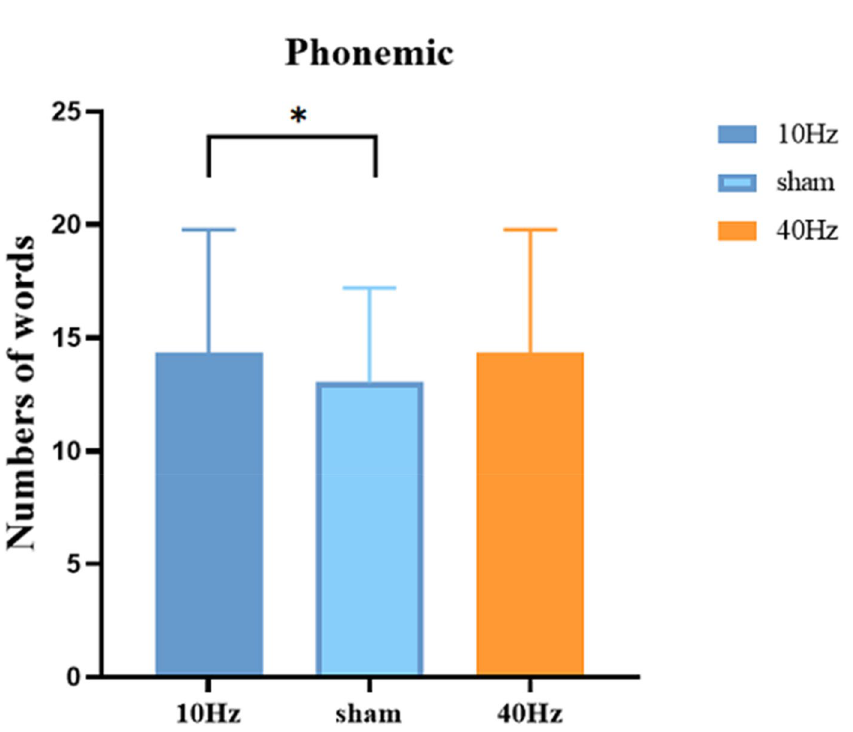
Figure 4. Phonemic fluency task results graph. The mean number of words for each consonant produced in the phonemic fluency